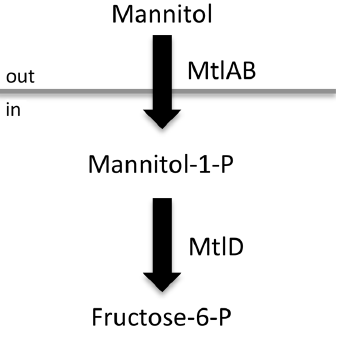
Figure 1. Mannitol uptake pathway in S.aureus . The mtlABFD operon encodes the Mtl-specific PTS (MtlAB) and the operon transcriptional repressor (MtlF); Mtl-1-P 5-dehydrogenase, encoded by mtlD , catalyses the conversion of Mtl-1-P to fructose-6-P which enters into the Embden-Meyerhoff and hexosemonophosphate glycolytic